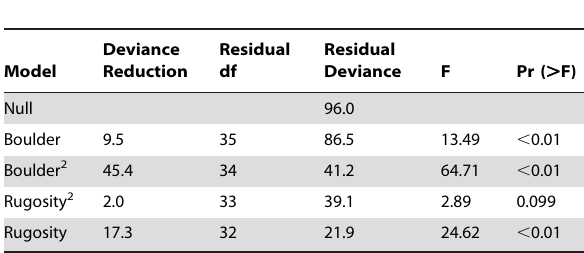
Table 3. Analysis of deviance for acoustic tagged green sturgeon habitat